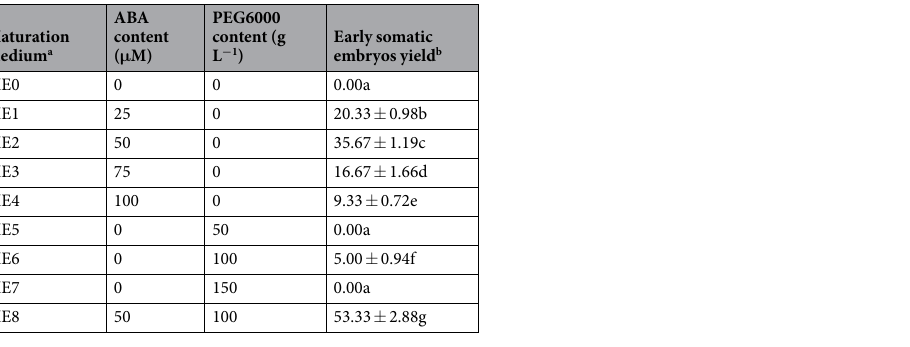
Table 3. Effect of ABA and PEG on somatic embryo maturation. a Maturation media ME1–ME8 were composed of DCR basal medium supplemented with various concentrations of ABA and PEG, 30 g L − 1 sucrose, 0.5 g L − 1 casein hydrolysate, 0.4 g L − 1 glutamine, 2.0 g L − 1 activated carbon, and 5 g L − 1 phytagel. b Duncan's new multiple range test was used to detected differences at P < 0.05. Different letters within a column indicate a significant